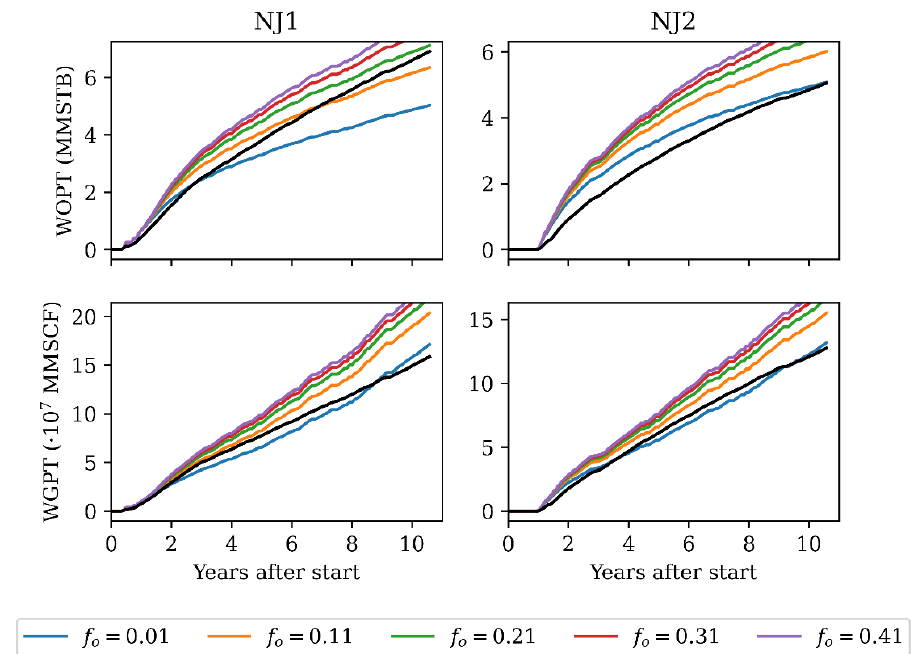
Figure 8. The production volumes for the North Jens model, corresponding to the different relative permeabilities in Figure 7. Black lines denote historical data.